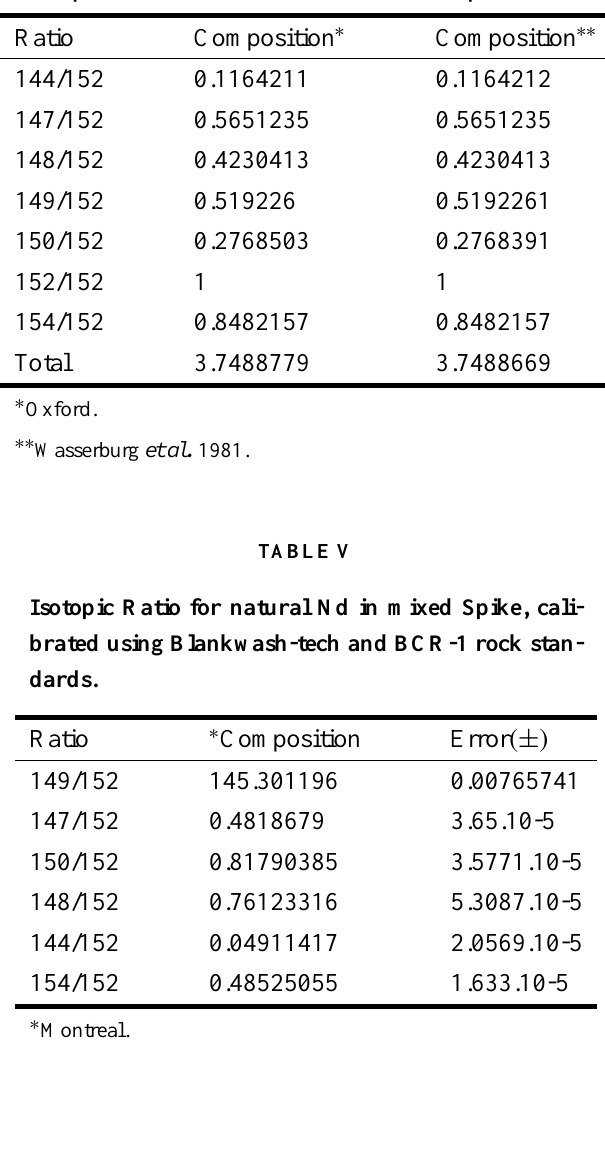
Isotopic Ratio for natural Sm used in the Isotopic Dilution